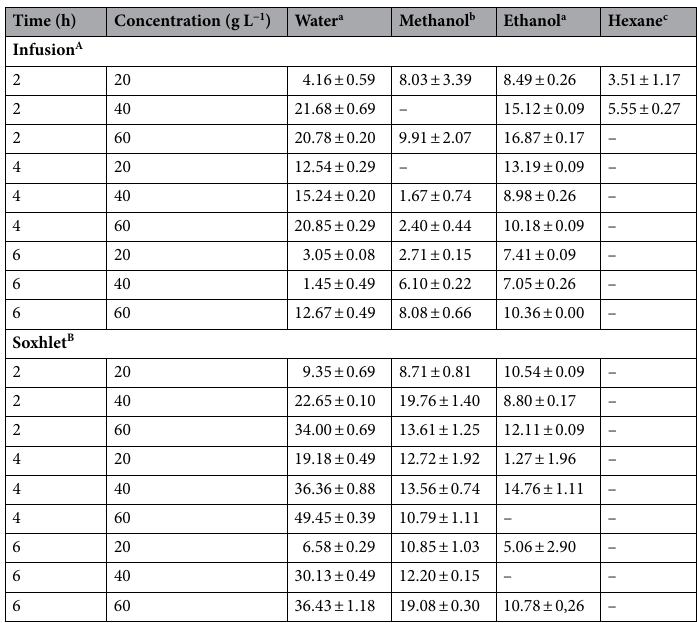
Table 2. Results of the t-test, for the percentage of DPPH radical capture, for the different extracting solvents and extraction methods. – Did not show antioxidant activity. *Equal letters represent that there was no significant difference between the means, with 95%